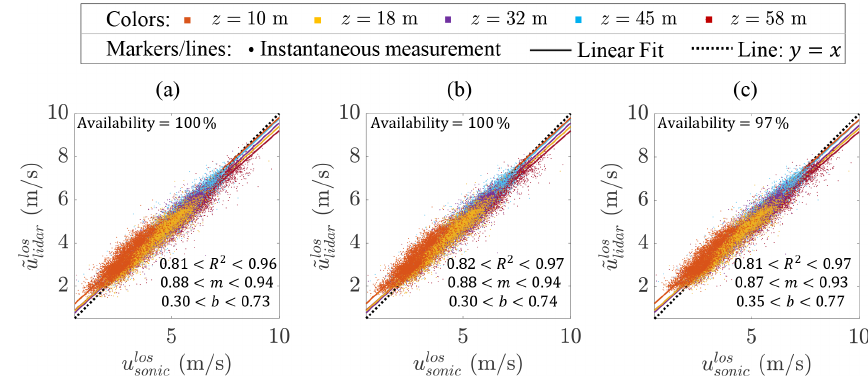
Figure 10. Instantaneous lidar line-of-sight spectral median velocity estimates, ˜ u los mates, u los , for inflow cases without solid interference from the (a) thresholding, (b) advanced filtering, and (c) machine learning tech- sonic niques. The variations shown for the coefficient of determination value, R 2 , the linear fit slope, m , and the linear fit offset, b , correspond to the ranges observed across the fits at all five comparison